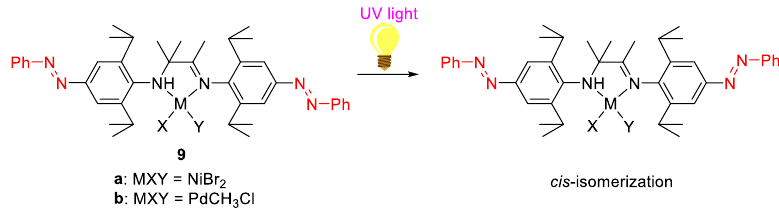
Figure 6. The azobenzene-functionalized amine – imine nickel and palladium catalysts.